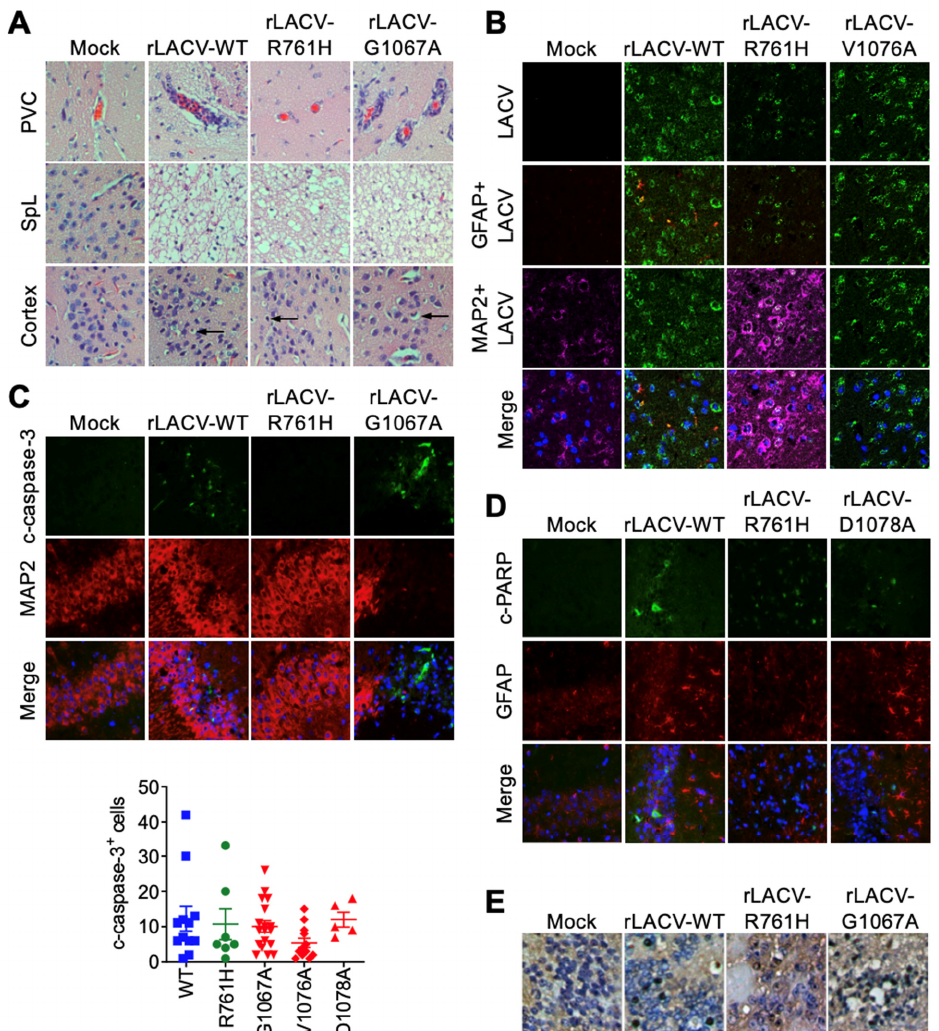
Figure 3. Histopathological changes and viral antigen in the brains of rLACV-infected, four-week-old mice challenged intracranially. ( A ) Hematoxylin and eosin staining of brains of moribund, four-week-old mice challenged with rLACVs showing perivascular cuffs (PVC), spongiform lesions (SpL), and degenerating neurons (arrows) in the cortex. ( B ) Immunofluorescence of LACV antigen (Green) in the dorsal thalamus (ventral to the hippocampus) of moribund mice (GFAP = Red; MAP2 = Purple; Nuclei = Hoecht’s, blue) demonstrating neuronal localization. ( C ) Cleaved-caspase-3 (Green) and MAP2 (Red) immunofluorescence in CA3 of the hippocampus of moribund mice. ( D ) Cleaved-PARP (Green) and GFAP (Red) immunofluorescence in CA1 of the hippocampus of moribund mice. ( E ) TUNEL-positive degenerating neurons (dark blue) and LACV antigen with hematoxylin counterstain. In contrast to young adult (P28) mice, suckling (P3) mice showed widespread